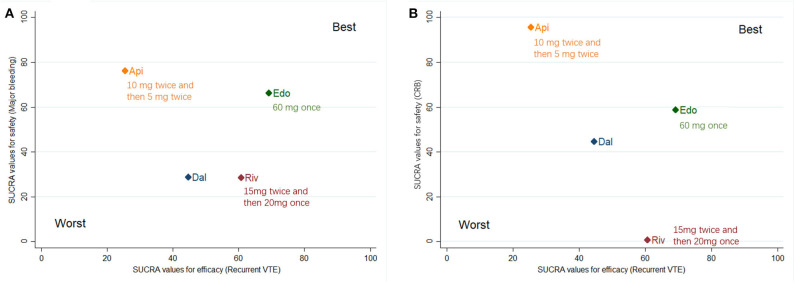
Surface under the cumulative ranking (SUCRA) plot. Ranking of treatments expresses the probability associated to each one being the best with respect to recurrent VTE and major bleeding (A), as well as recurrent VTE and CRB (B). Treatments in the upper right corner are more effective and safer than the other treatments. VTE, venous thromboembolism; CRB, clinically relevant bleeding; Dal, dalteparin; Edo, edoxaban; Riv, rivaroxaban; Api, apixaban.